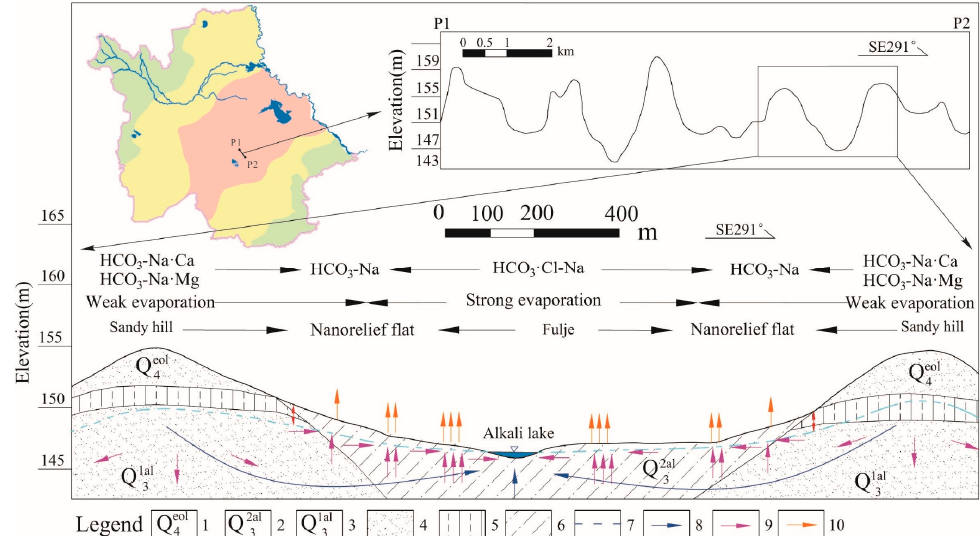
Figure 5. Hydrogeochemical evolution controlled by micro-topography. (1) aeolian deposit of Holocene, (2) upper part of Upper Pleistocene (lacustrine sediment), (3) lower part of Upper Pleistocene (lacustrine sediment), (4) fine sand, (5) loess loam, (6) sandy loam, (7) unconfined water level, (8) groundwater flow direction, (9) salinity transport direction, and (10)